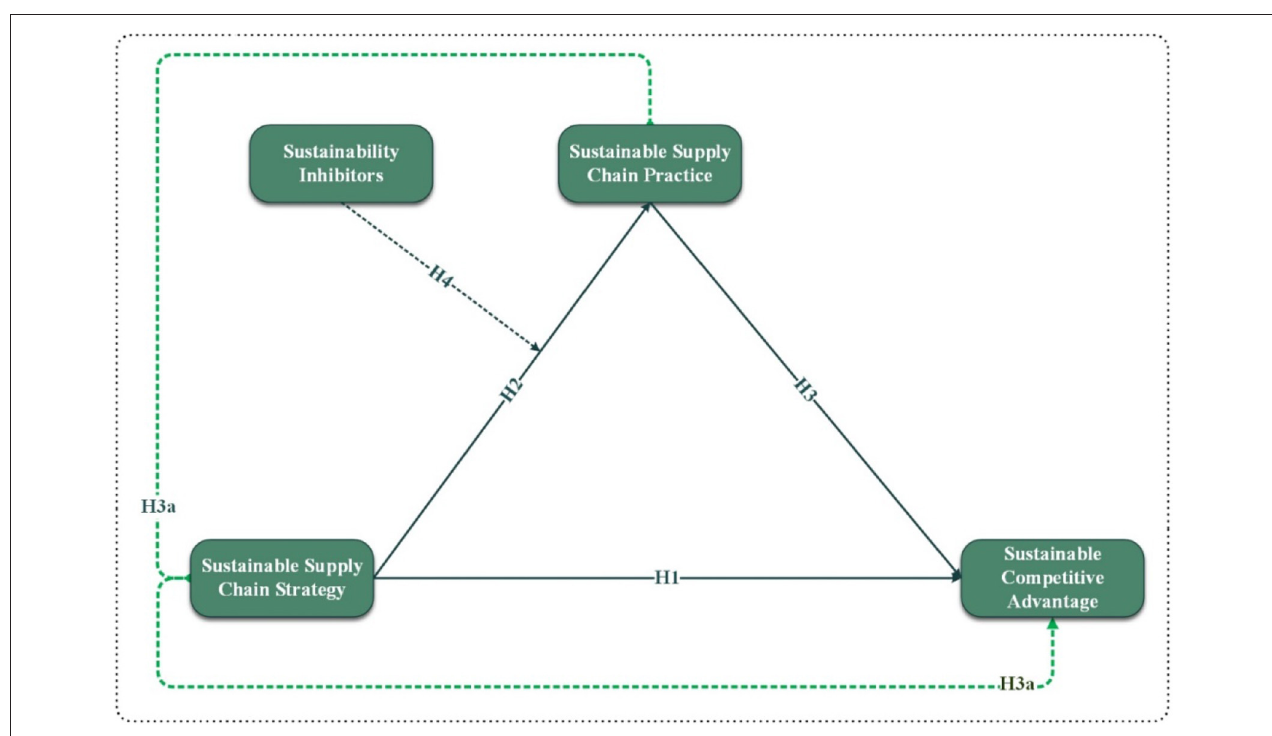
FIGURE 1 | Conceptual framework.